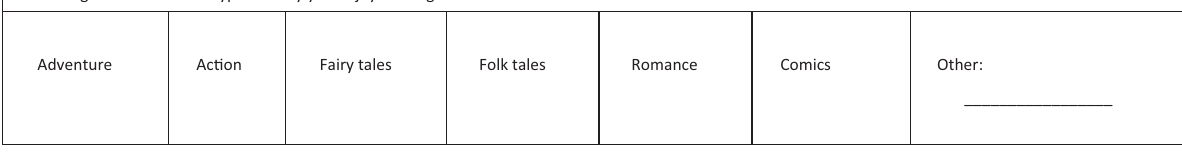
S(cid:30)ck two green stars on the type of story you enjoy reading the least.